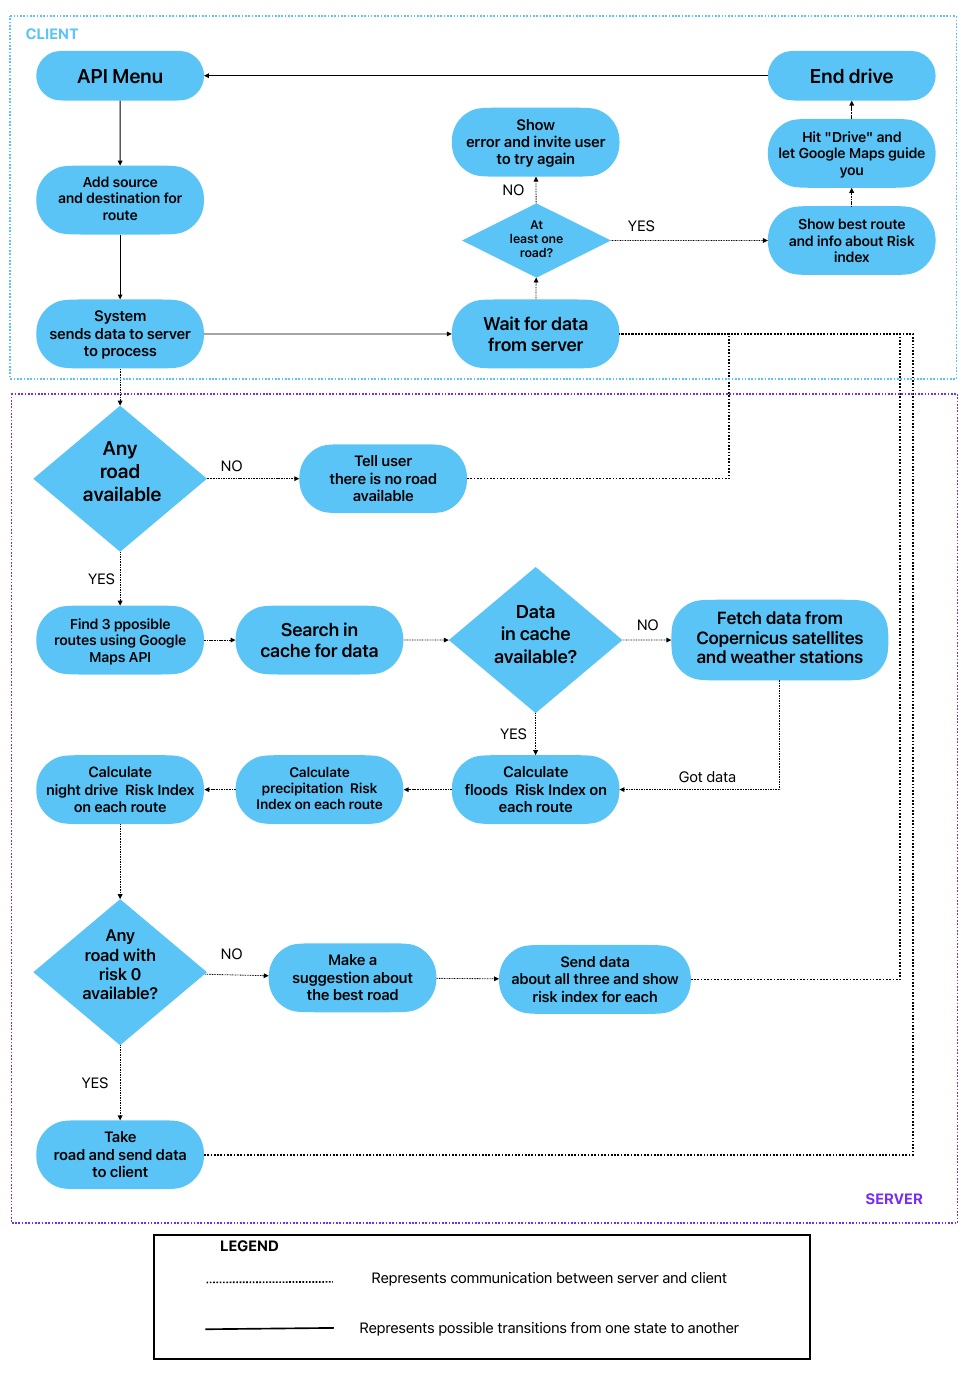
Figure 1. Workflow of the back-end